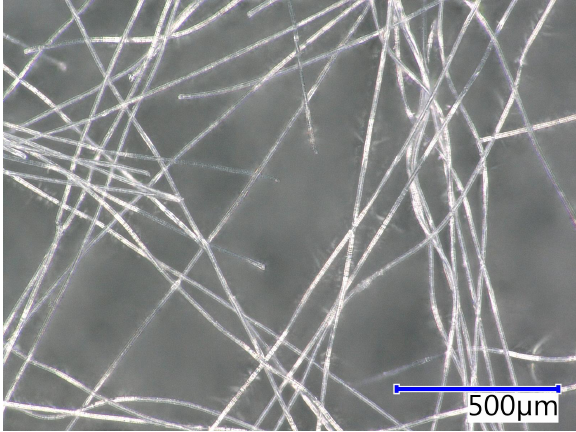
Figure 1. Detail image of PET